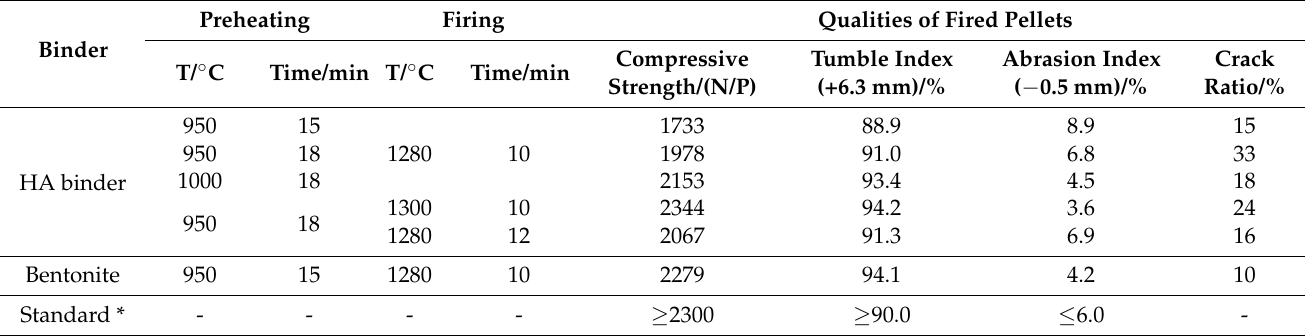
Table 3. Effect of preheating and firing parameters on the qualities of fired VTM pellets using HA binder or bentonite binder.